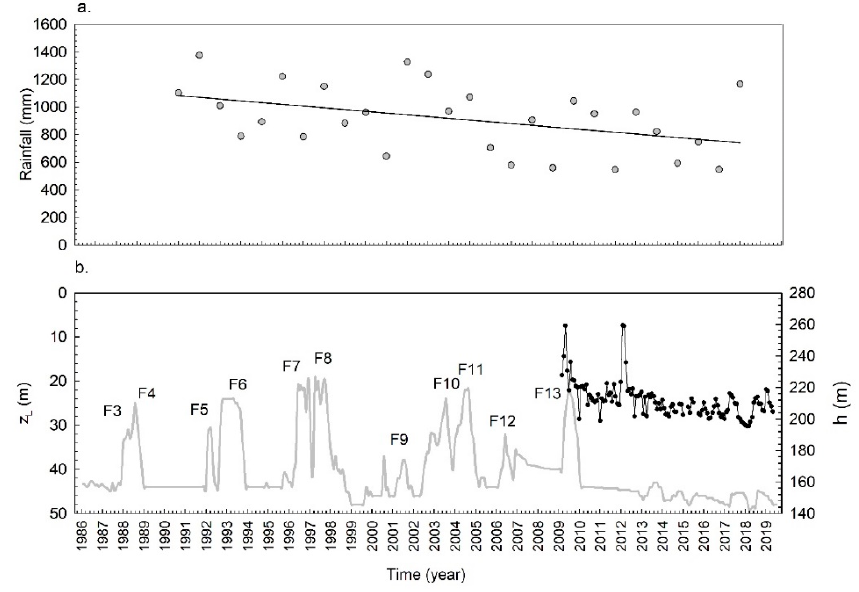
Figure 4. Temporal evolution of the rainfall at the Darnius weather station ( a ). Temporal evolution of the depth of the lutocline (z L ) (continuous grey line) and the piezometric level of the aquifer in Banyoles (black solid circles) (h) ( b ). F1–F13 correspond to the fluidization events observed by monitoring the lutocline depth with time.